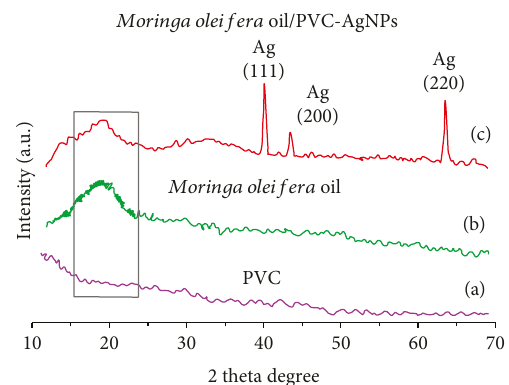
Figure 4: XRD pattern of (a) plain PVC, (b) Moringa oleifera oil, and (c) Moringa oleifera oil/PVC-AgNP